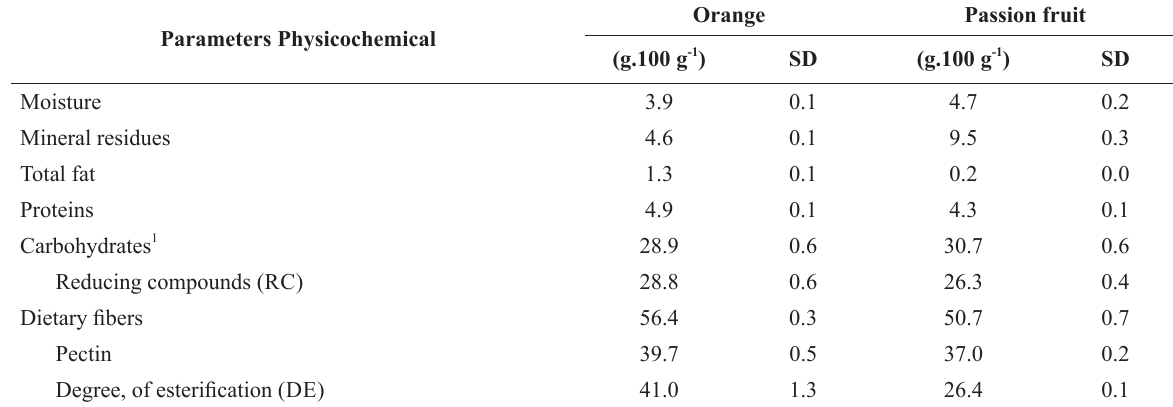
Physicochemical composition of orange pear and yellow passion fruit wastes.